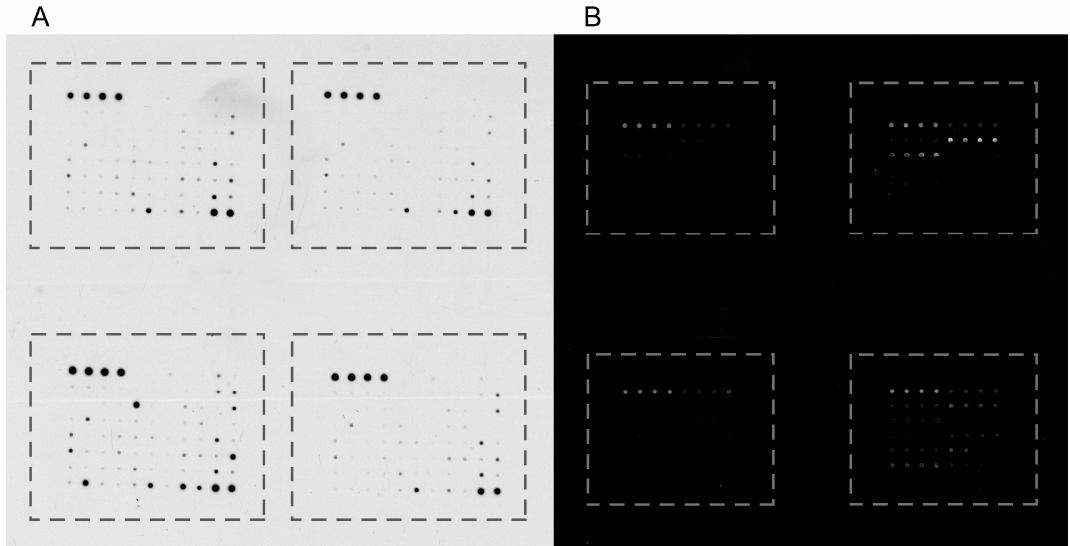
Figure 4. Planar antibody arrays for detection of secreted cytokines. ( A ) Membrane array with chemiluminescent detection; ( B ) glass array with fluorescent detection. Positions of individual subarrays (4 individual samples) are highlighted by dashed line.